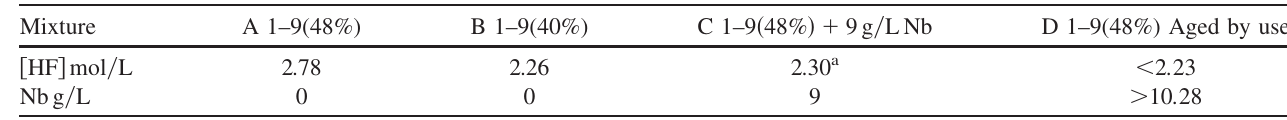
TABLE I. Formulation of the studied mixtures.